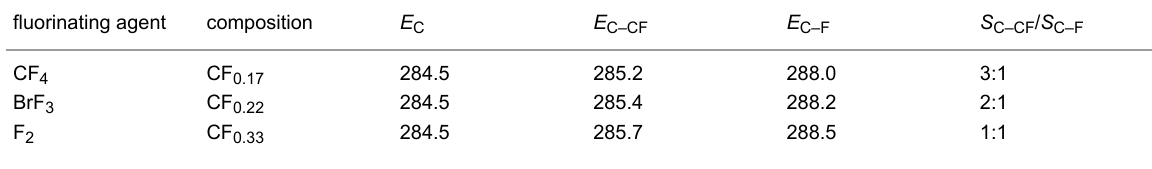
Table 1: Composition (CF x ) of fluorinated DWCNT samples, energy positions (eV) of components of XPS C 1s spectra, and ratio of integral intensi- ties of the C–CF and C–F components. fluorinating